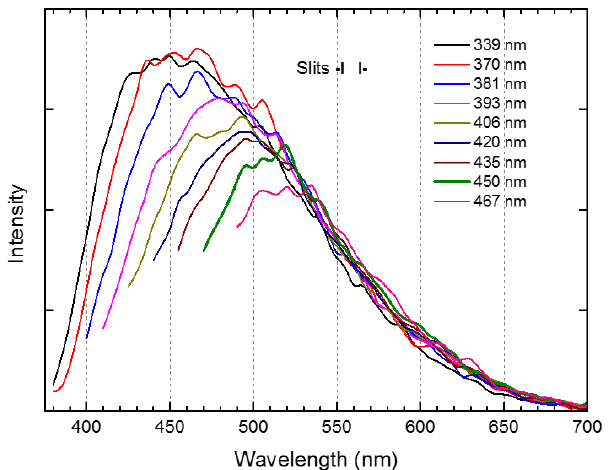
brackets.Fig. 5. Fluorescence bands of urine fraction powder at various excitation wavelengths at 77 K. An average spectral width of the monochromator slits is shown by